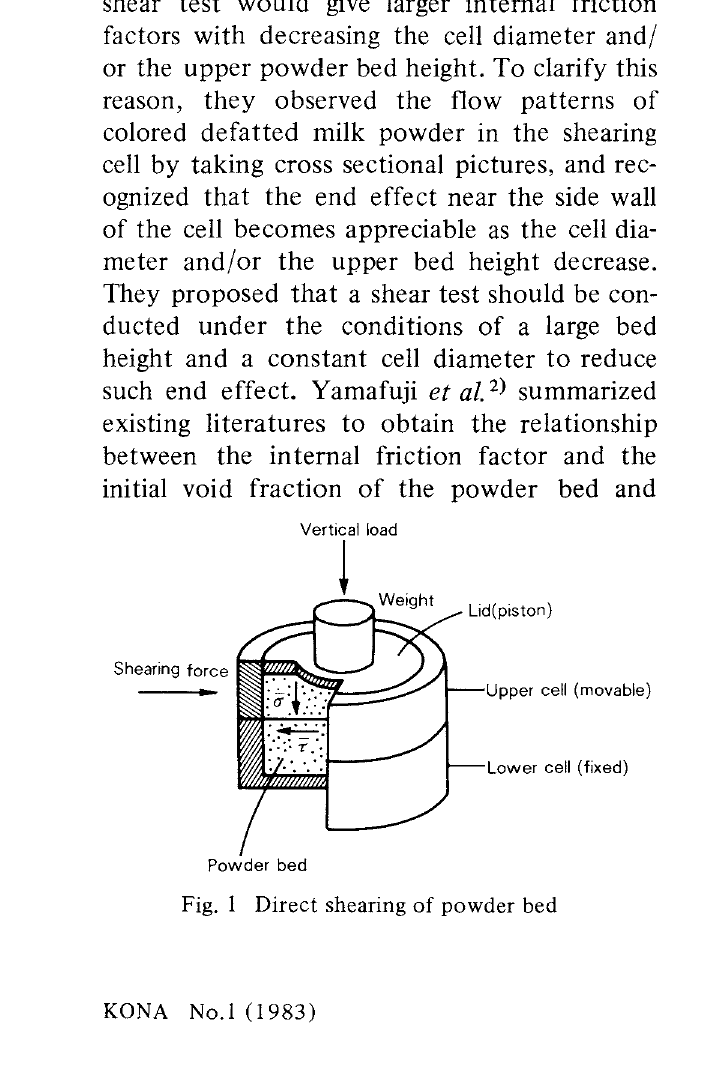
Fig. 1 Direct shearing of powder